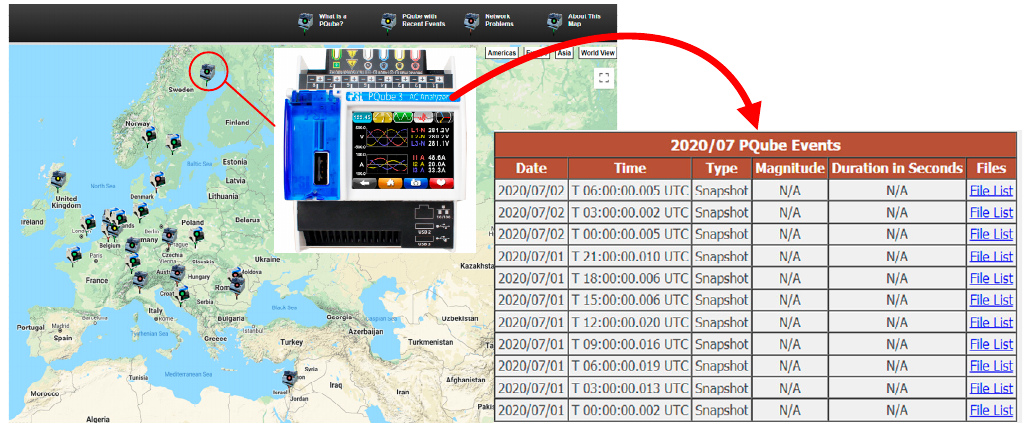
Figure 20. The oscillatory transient when the bank of the capacitor at bus node 675 switches on. Based on the above analysis results of the PQ events generated using the IEEE 13-bus system,